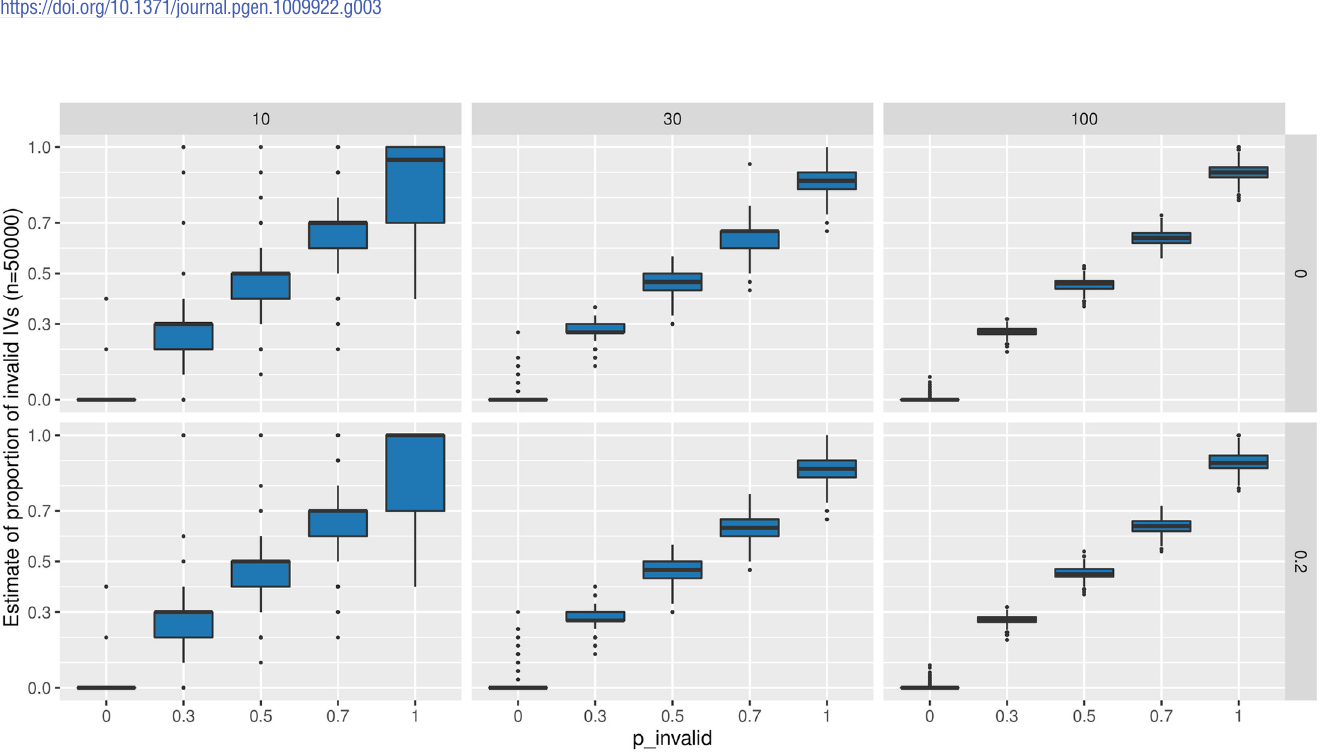
Fig 4. Estimates of the proportion of invalid IVs by mixIE-MA with n = 50 000 under directional pleiotropy and InSIDE satisfied. The upper row corresponds to θ = 0 and the lower one to θ = 0.2; each column corresponds to m = 10, 30, 100 respectively.